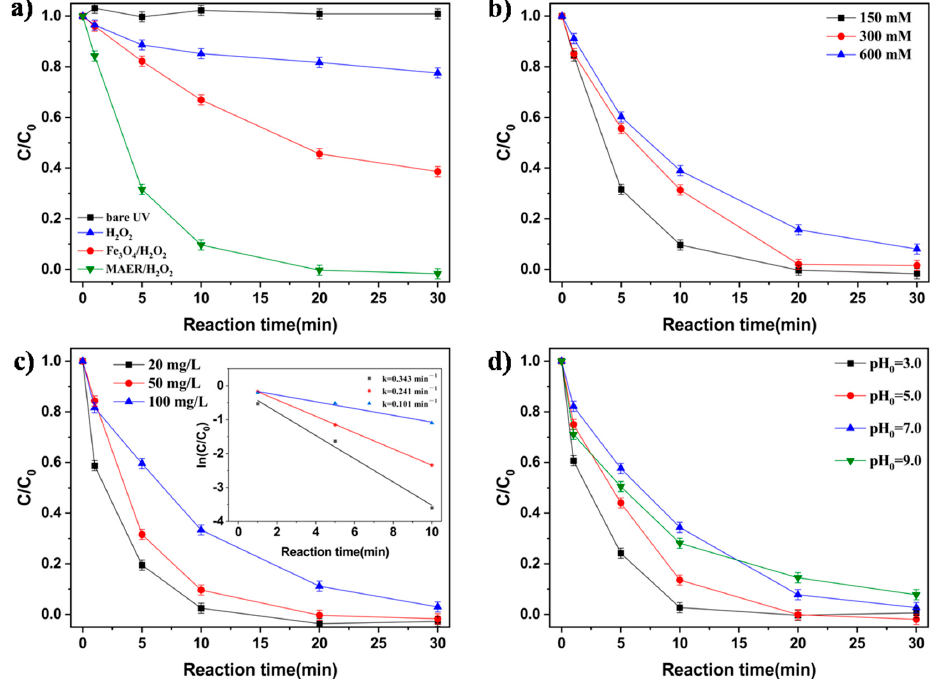
Figure 4. ( a ) Removal of X-3B by different reaction systems, effects of ( b ) H 2 O 2 dosage, ( c ) initial concentration of X-3B, and ( d ) initial pH value on removal efficiency of X-3B in a MAER UV–Fenton system. Reaction conditions (unless